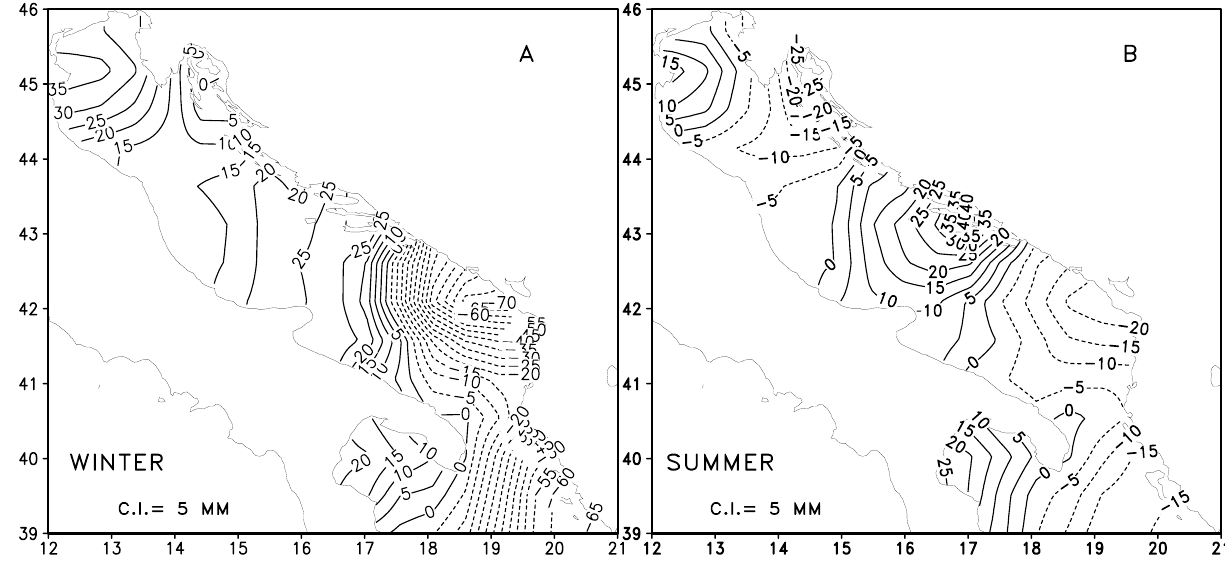
Fig. 4. Seasonal climatological (E-P) interpolated in the AIM grid. (A) : winter, (B) : summer. Contour interval is 5mm. Seasons definition as in Artegiani et al. (1997a,